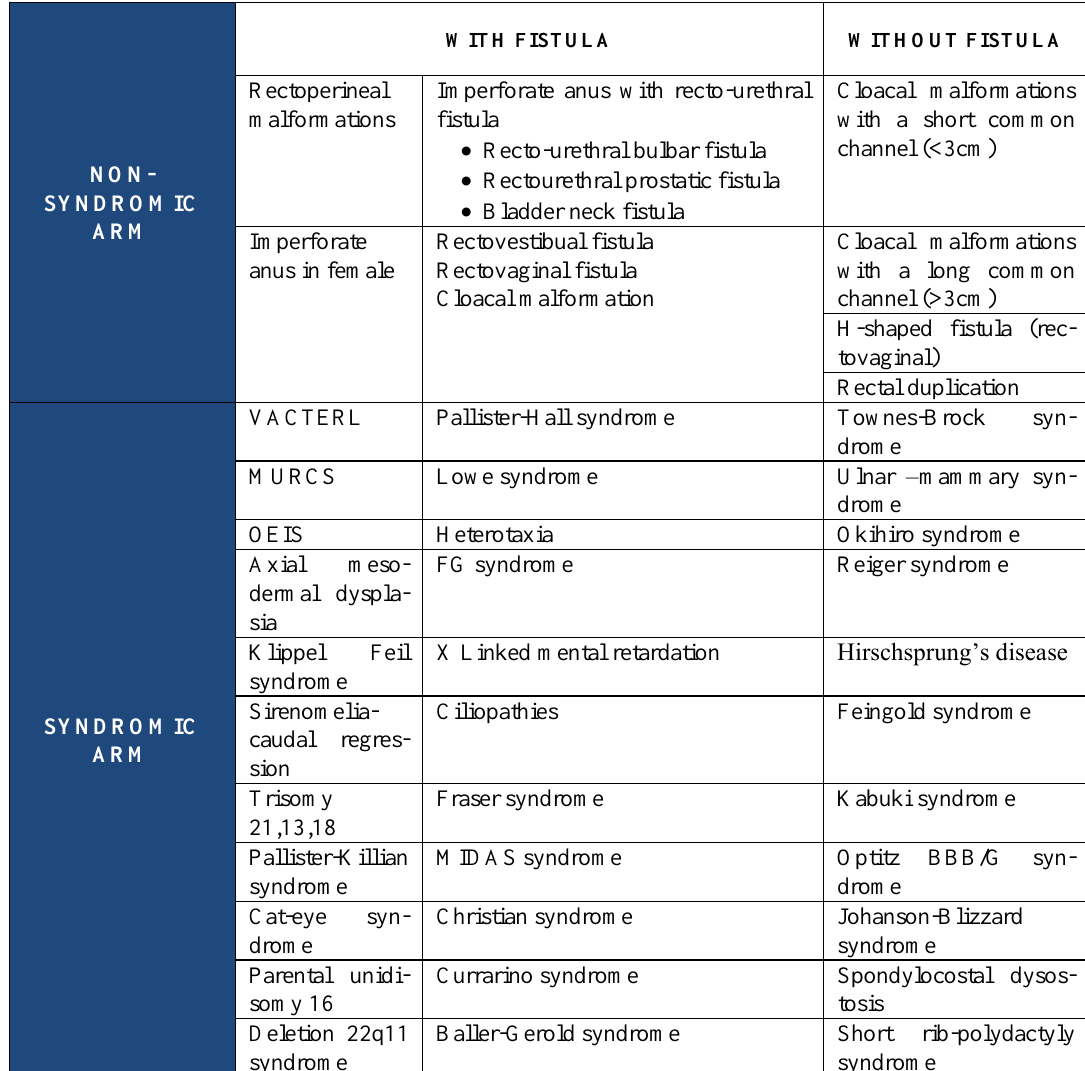
Table 3: Pena’s classification of ARM